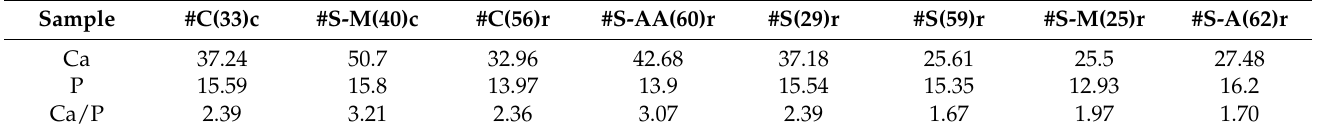
Table 2. Calcium and phosphorus contents of the eight selected crown enamel and root samples from EDS analyses. The reported values (expressed in %) were obtained at a 4000 ×